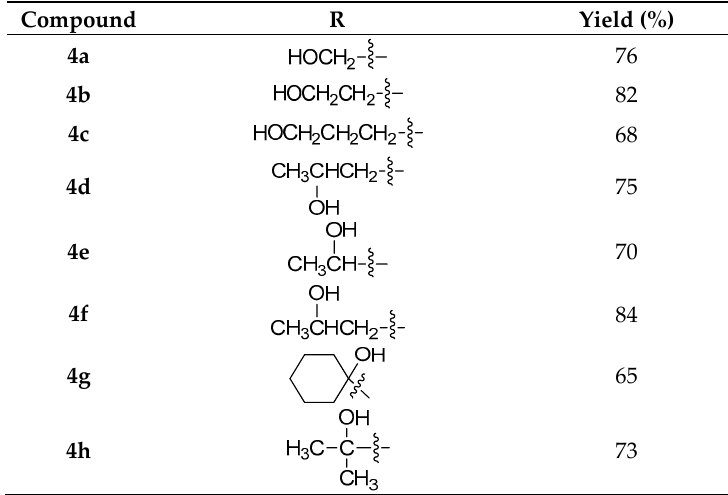
Table 1. Mean values for mycelial growth (cm) of Colletotrichum gloeosporioides treated with triazoles ( 4a  4h ). Compounds